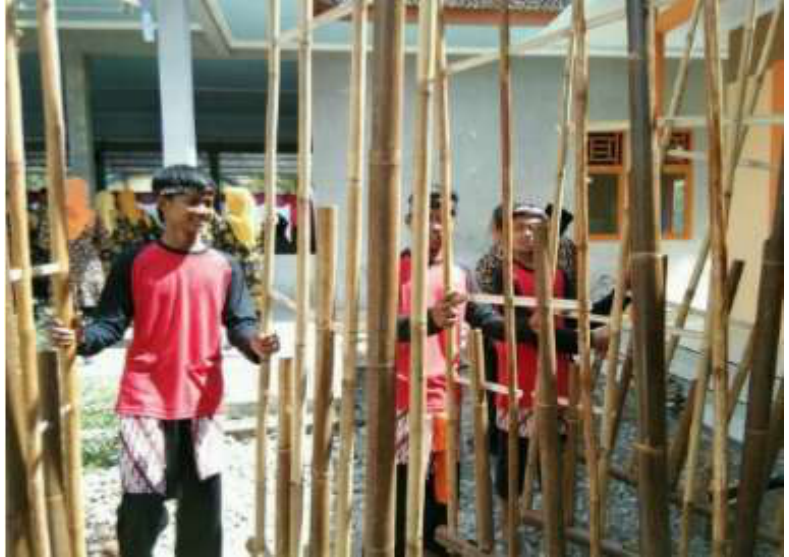
Figure 7. Angklung Mang